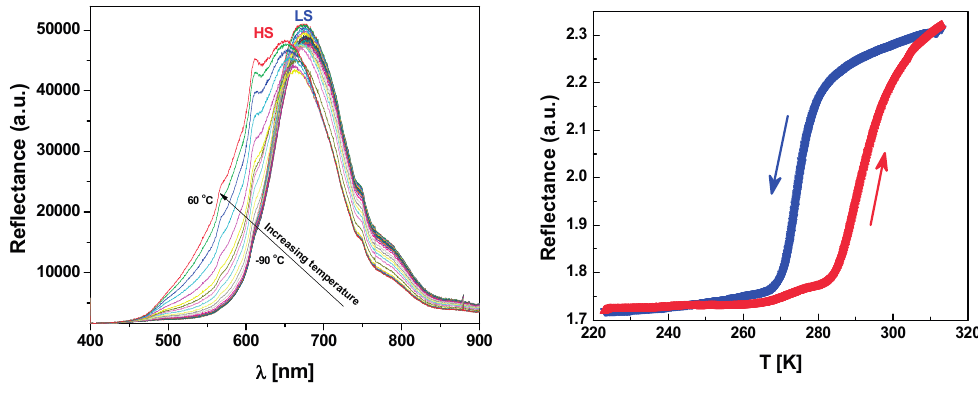
Figure 2. Thermal evolution of reflectance spectra recorded on [Fe(hyetrz) 3 ]I 2 ·I 2 O in the solid state ( left ) and of the optical density at λ = 550 nm ( right